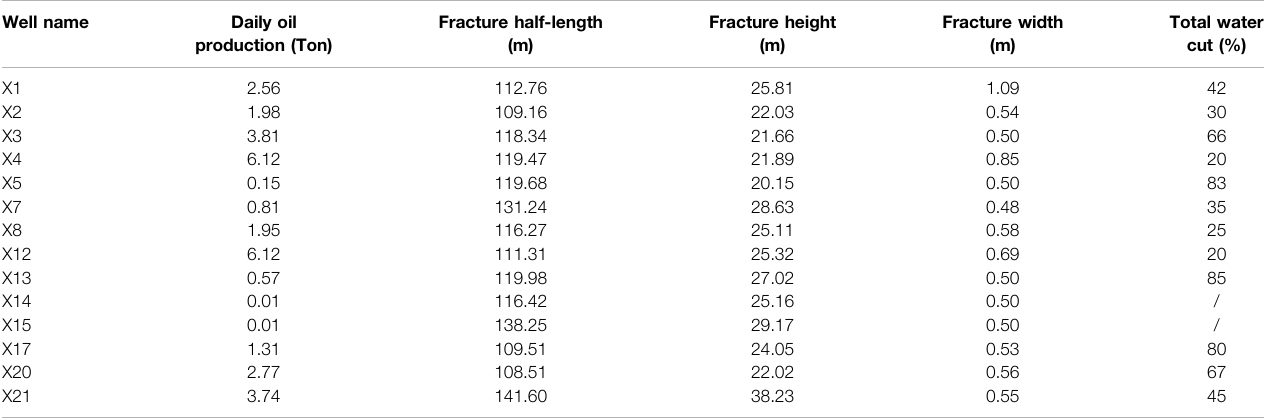
TABLE 1 | Numerical simulation results of various fracture parameters in fractured horizontal